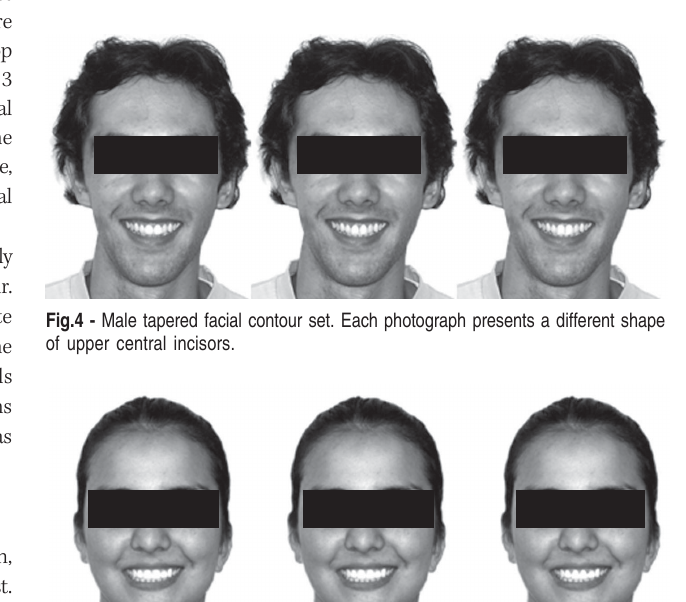
Fig. 3 - Female tapered facial contour set. Each photograph presents a different shape of upper central incisors.